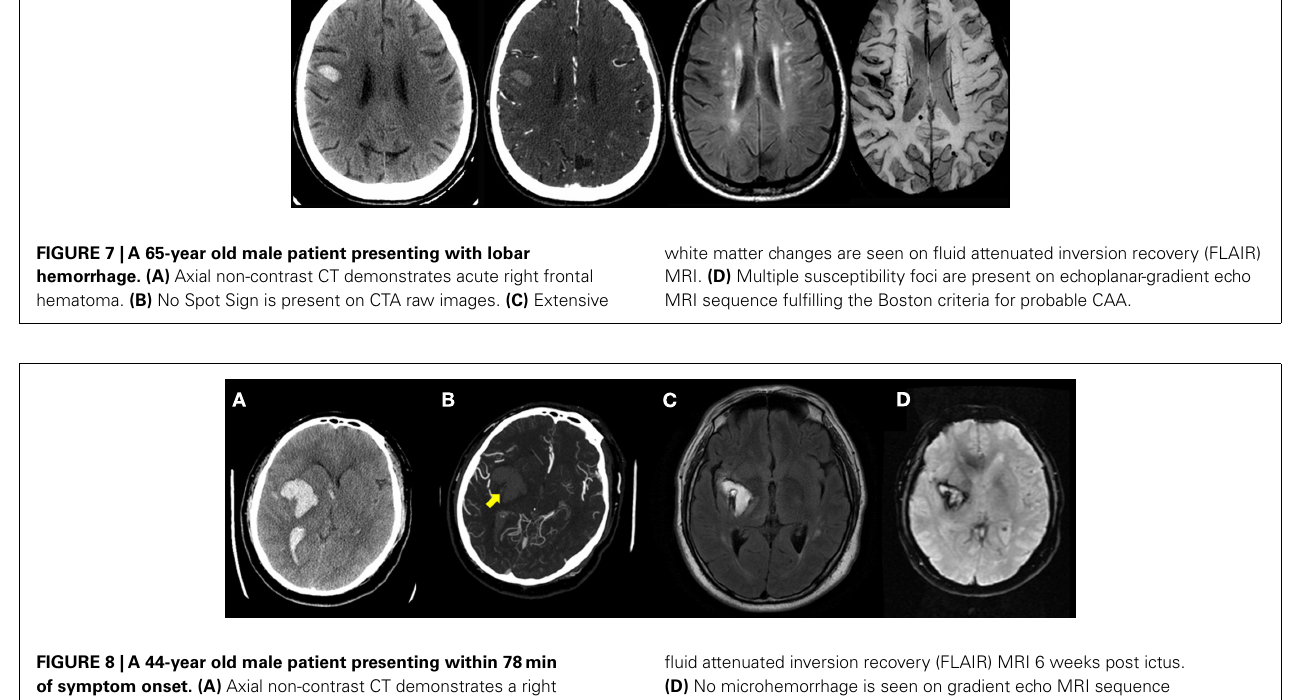
FIGURE 8 |A 44-year old male patient presenting within 78min of symptom onset. (A) Axial non-contrast CT demonstrates a right basal ganglia intracerebral hemorrhage. (B) Spot Sign present on CTA source images. (C) Right basal ganglia hematoma visualized on